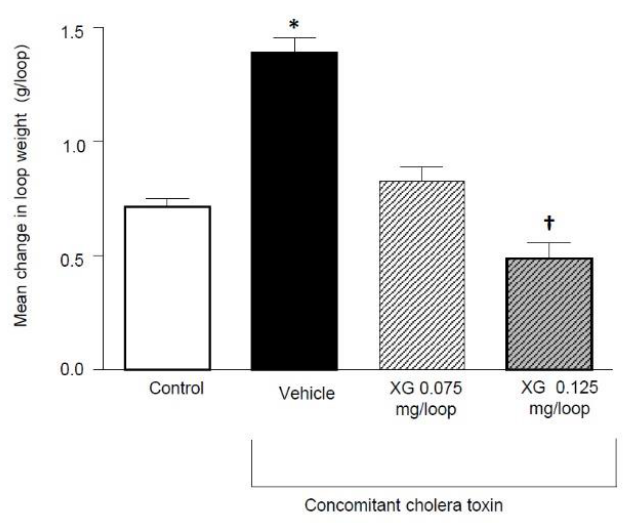
Figure 3. Local (intra-jejunal loop) administration of xyloglucan 0.125 mg/loop significantly attenu- ated cholera toxin-induced intra-loop water secretion relative to vehicle in isolated jejunal loops of anesthetized rats ( n = 8/group). * p < 0.05 vs. control, † p < 0.05 vs. vehicle. 2.2.2. Duration of Protective Effect with Gelatin Tannate, Xyloglucan, and Gelatin (Alone or in Combination) After CT challenge for 2 h, the mean weight of the intra-loop contents was increased by 40% to 50% relative to control. Pretreatment with single-dose oral xyloglucan 12.5 mg + gelatin 125 mg/kg 6 h prior to CT challenge significantly ( p < 0.05) attenuated mean CT-